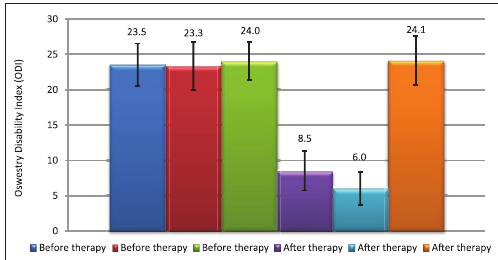
FIGURE 1. Average values of the oswestry disability index before and after